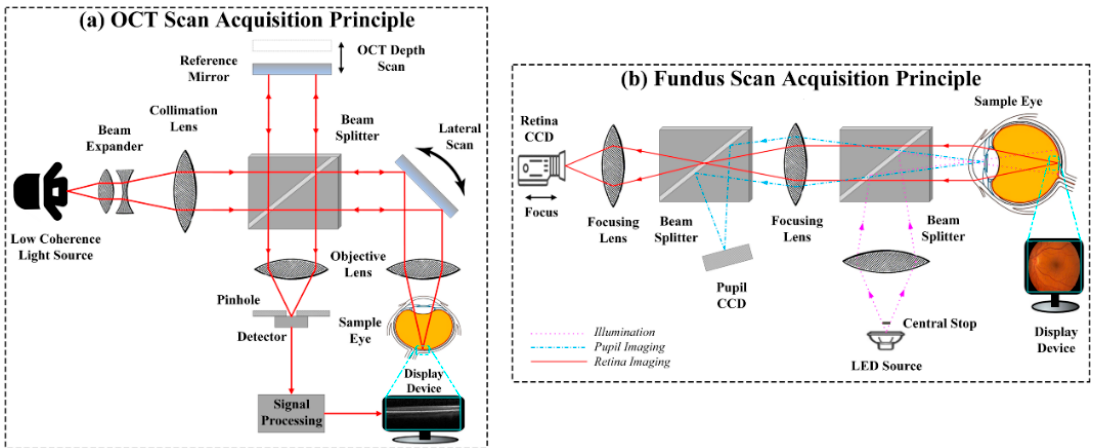
Figure 1. Working principle of retinal imaging modalities. ( a ) Optical coherence tomography (OCT) scan acquisition principle and ( b ) the fundus scan acquisition principle.